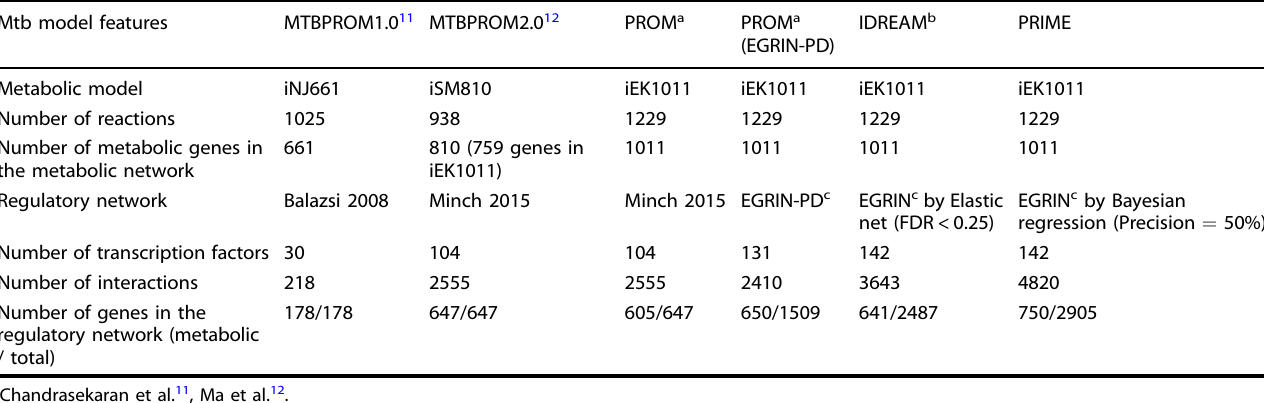
Table 1. Summary of PROM, IDREAM, and PRIME model features. Mtb model